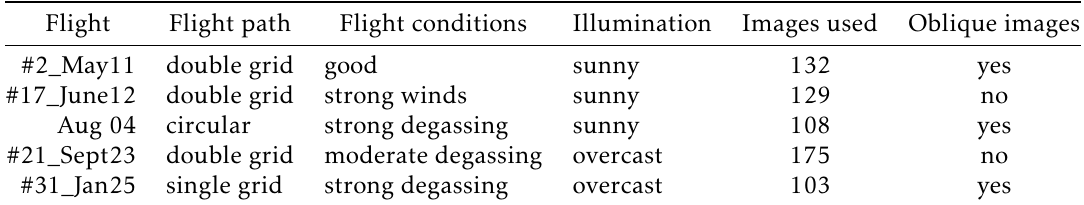
Table A2: Flight parameters for the five survey flights perfomed between May 2019 and January 2020. The flight name corresponds to the internal LMU